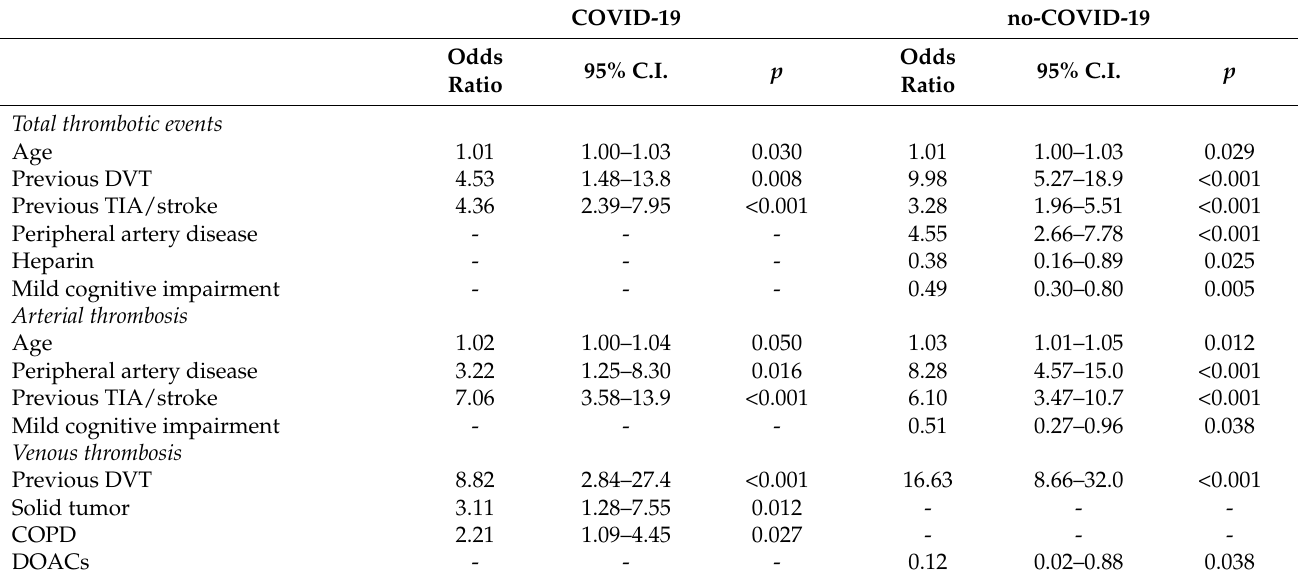
Table 7. Main results of multivariable analysis in the two groups of